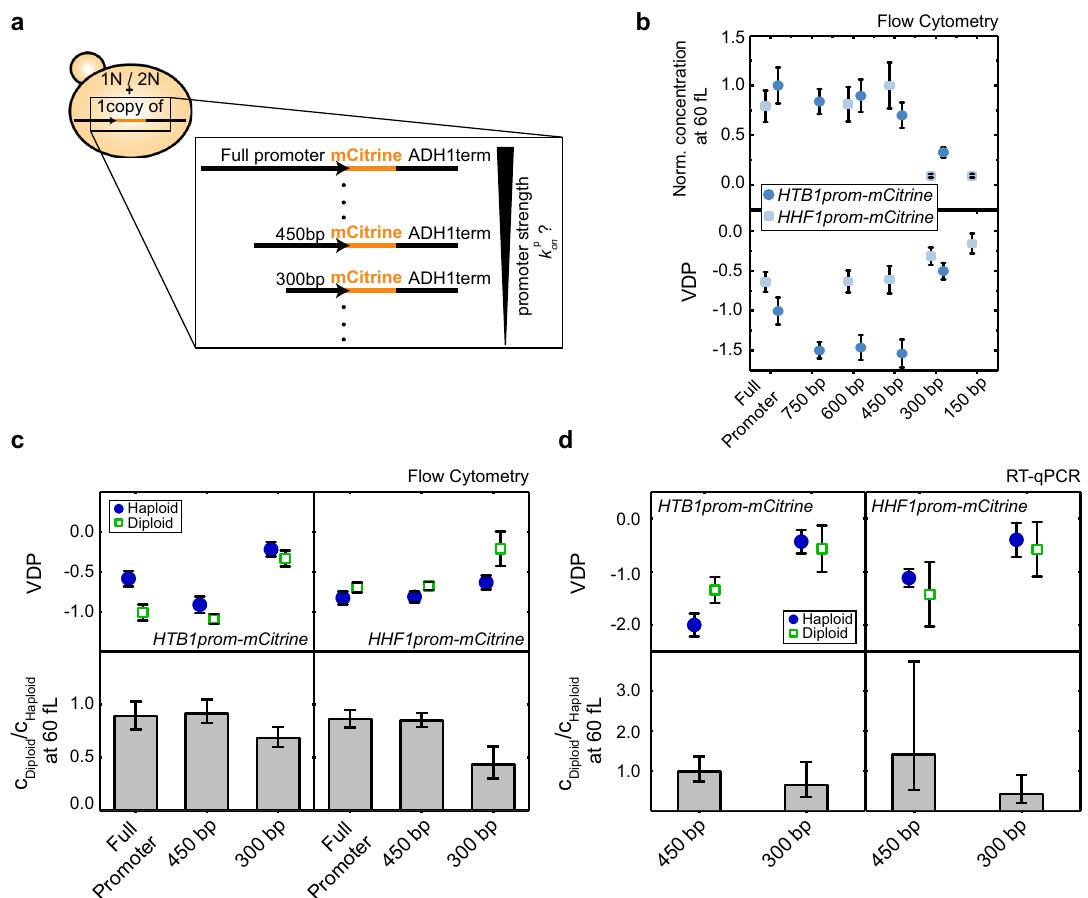
Fig. 6 Reducing the strength of a histone promoter shifts its behavior from histone-like to actin-like. a Illustration of a series of haploid and diploid strains carrying a single additional copy of increasingly shorter fragments of promoters driving mCitrine expression, each truncated from the 5 ′ -end. b mCitrine concentration at 60fL normalized on maximum concentration of the respective promoter (upper panel) and VDP of mCitrine (bottom panel) determined by fl ow cytometry for the respective promoter truncations of the HTB1 promoter (dark blue circles) and the HHF1 promoter (light blue squares) driving mCitrine expression, integrated in haploid cells. Concentrations were estimated from a linear fi t to the double logarithmic dependence of concentration on cell volume, VDPs were determined as the slope of the linear fi t ( fi t through n HTB1prom full propagation of the 95% con fi dence interval of the linear fi t at 60fL. In the bottom panel, error bars show the standard error of the VDPs. c VDP of mCitrine in haploid (blue fi lled circles) and diploid (green open squares) cells (upper panel) and mCitrine concentration at 60fL in diploids compared to the concentration in haploids (bottom panel) determined by fl ow cytometry. Left shows results for the HTB1 promoter truncations, right shows results for the HHF1 promoter truncations. Concentrations were estimated from a linear fi t to the double logarithmic dependence of concentration on cell volume, VDPs were determined